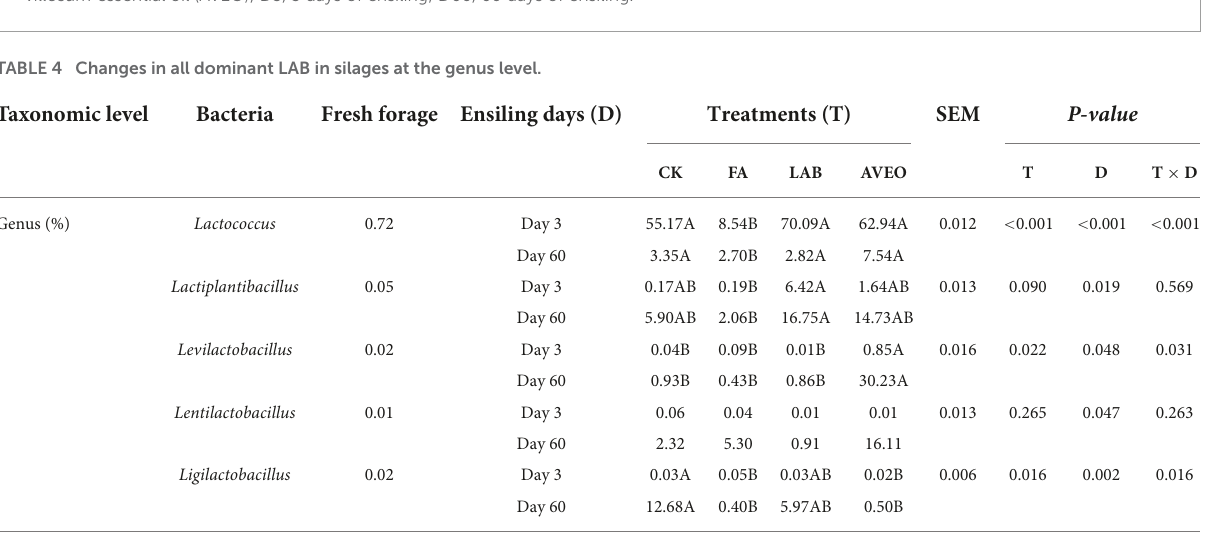
FIGURE1 Relative abundance of the bacterial community at the phylum (A) and genus (B) levels in fresh paper mulberry and the control treatment without additives (CK) or with formic acid (FA); Lactiplantibacillus plantarum combined with Lactiplantibacillus buchneri (LAB); Amomum villosum essential oil (AVEO); D3, 3 days of ensiling; D60, 60 days of ensiling.